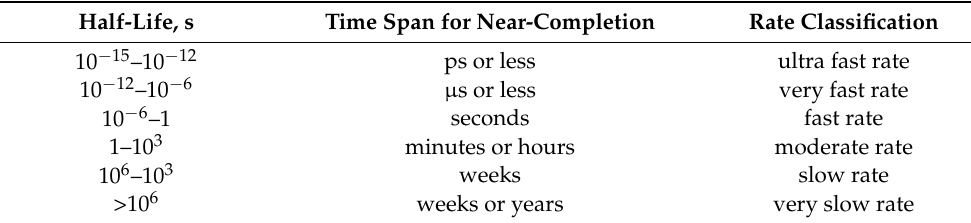
Table 4. Classification of reaction rates based on half-lives